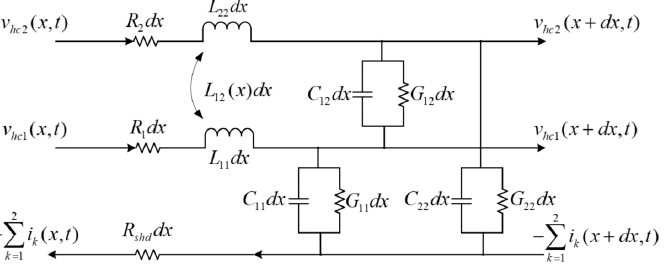
Figure 2. Helix coil sensors equivalent RLCG transmission model per dx .